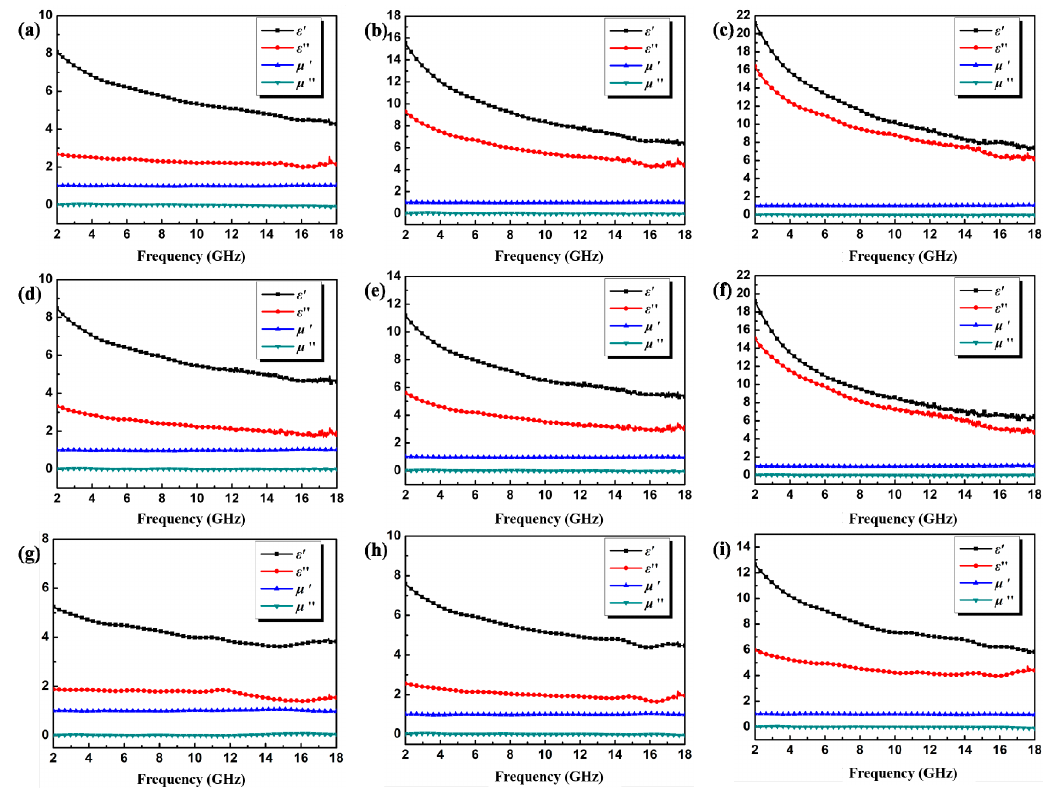
Figure 5. Frequency dependence of the ε′ , ε″ , μ′ , and μ″ values of sample A with filler loadings of 4 ( a ), 6 ( b ), and 8 wt% ( c ); sample B with filler loadings of 4 ( d ), 6 ( e ), and 8 wt% ( f ); and sample C with filler loadings of 4 ( g ), 6 ( h ), and 8 wt% ( i ).